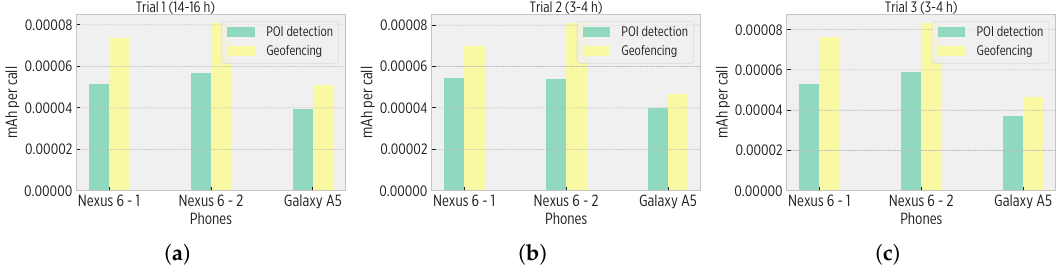
Figure 10. Energy overhead of perceptors different trials. ( a ) A trial of 14–16 h length, ( b ) A trial of 3–4 h length, ( c ) A trial of 3–4 h length. Based on the estimated consumption (mAh per call) and battery characteristics, the Nexus 6 would execute the pois _ detector module for 60 h and the gf module for 46 h. the Galaxy A5 would achieve 20 h and 23 h,